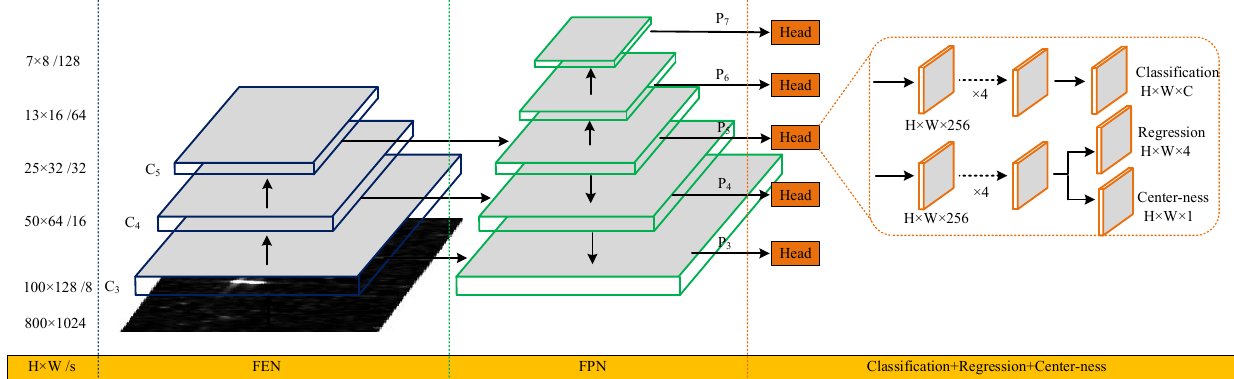
Figure 1. Architecture of the FCOS network. H × W denotes the height and width of feature maps. C denotes the number of classes, and ‘/s’ denotes the down-sampling ratio of the feature maps at the level to the input image. As an example, all the numbers are computed with an 800 × 1024 input.